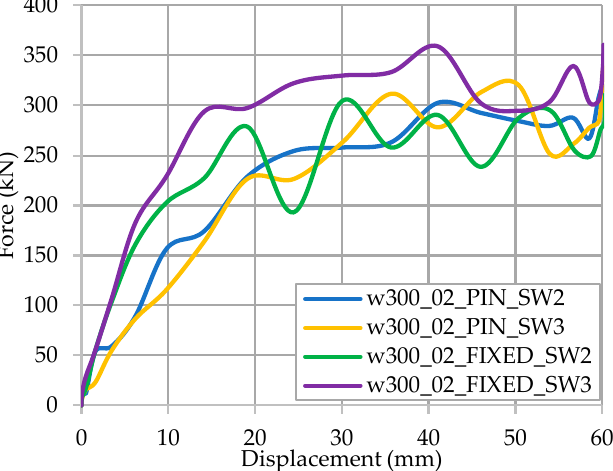
Figure 25. Force/displacement diagrams for 2 SW and 3 SW configurations of the pinned and fixed beam with shear connectors spaced at 300 mm.